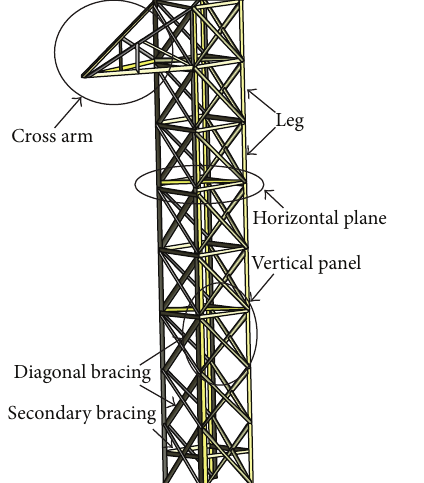
Figure 5: Three dimensional view of studied tower 1.